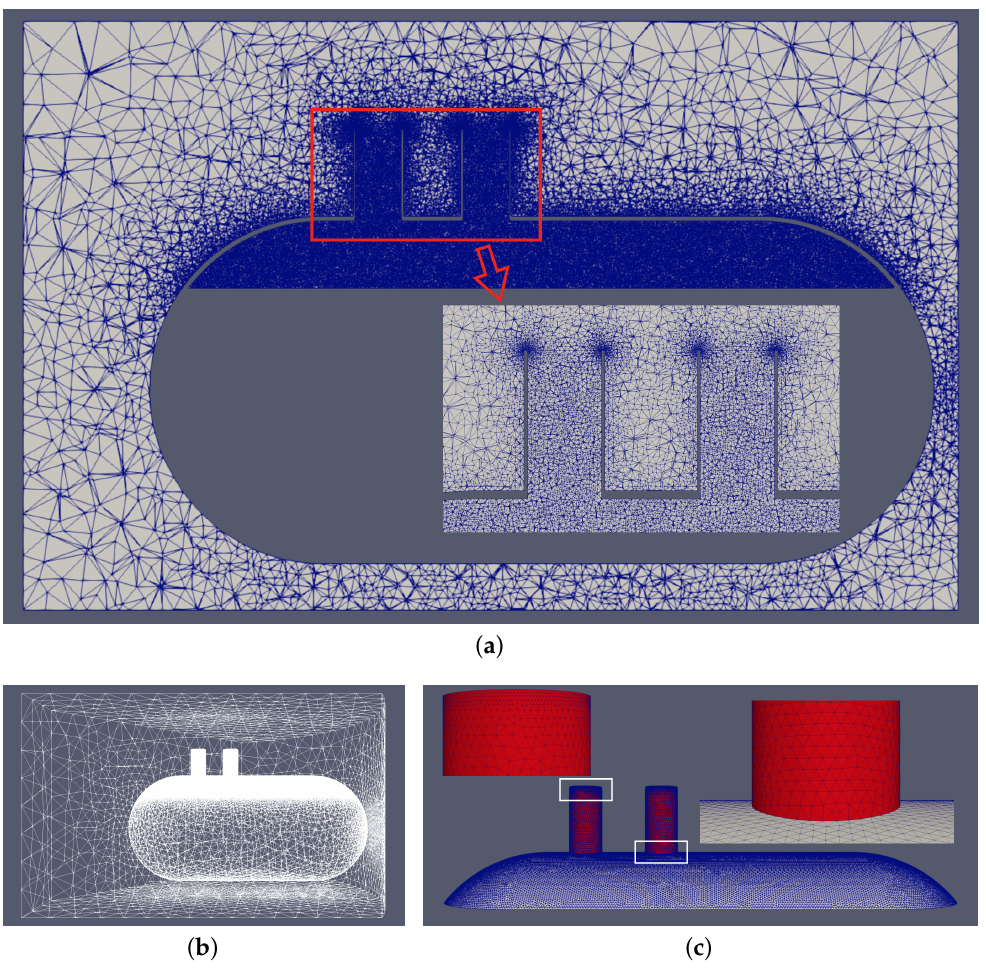
Figure 3. The numerical mesh of the steam dumping process of the PRT, in which panel ( a ) is the mesh at the cross section, panel ( b ) is the overall grid, and panel ( c ) is the mesh detail of the gas chamber of the PRT. The mesh contains 573,583 points, 6,450,280 faces (6,286,476 internal faces), and 3,184,189 cells, which are tetrahedra.